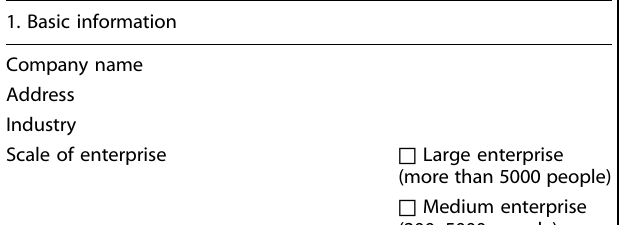
Table 7. The general questionnaire used for the Hoar method in the present